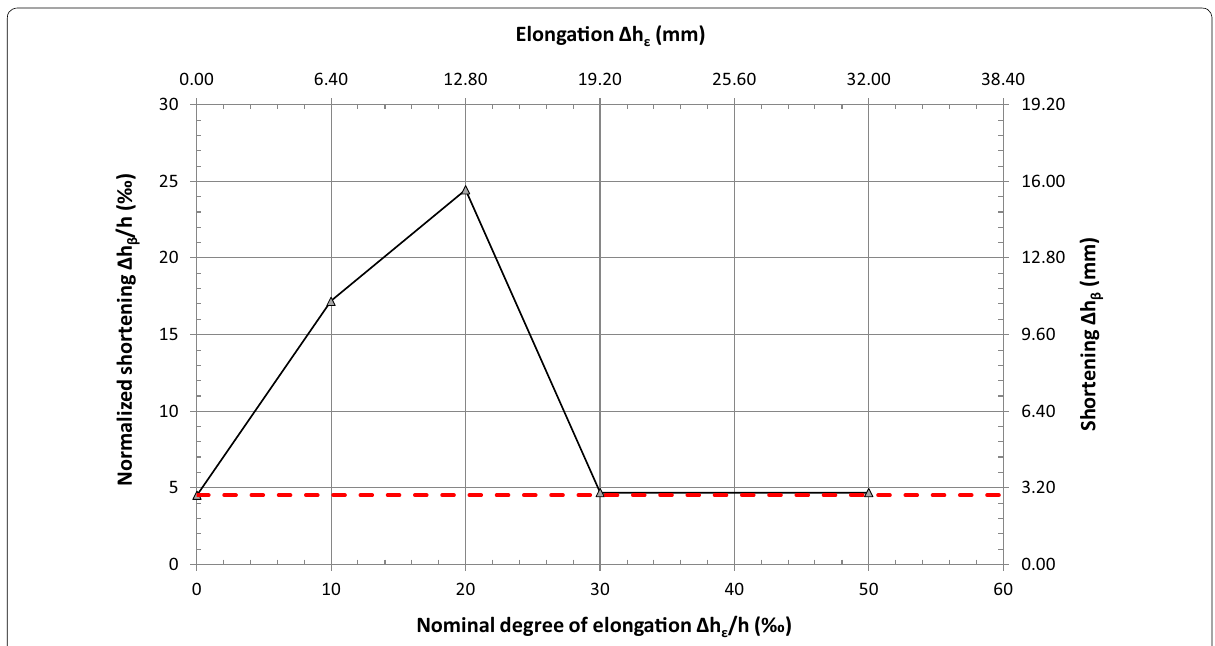
Fig. 12 Variation of shortening at failure versus the degree of elongation.